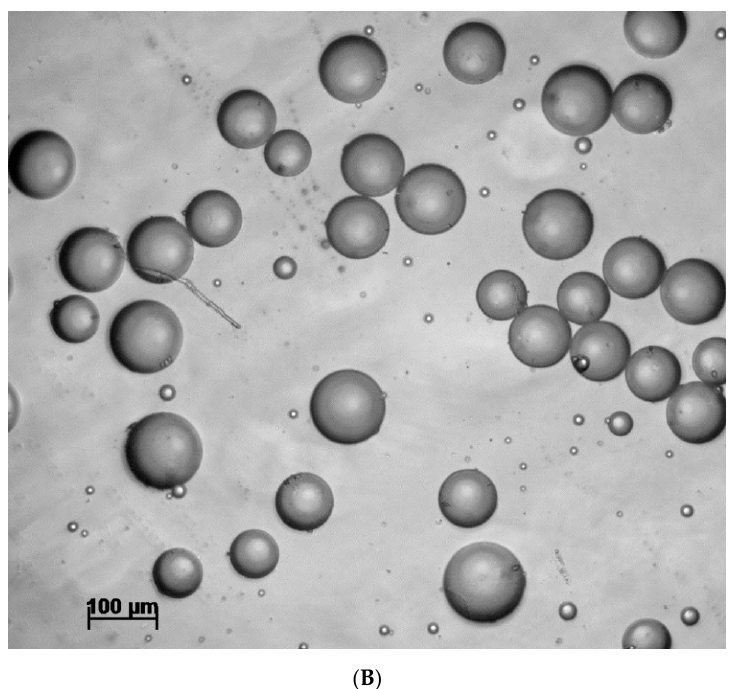
Figure 2. The representative snapshots of EAT adipocytes of patients from groups of patients with non-hypertrophied EAT adipocytes and with hypertrophied EAT adipocytes. ( A ) Patient from group of patients with non-hypertrophied EAT adipocytes, median of adipocytes diameter is 80.27 µ m; ( B ) patient from group of patients with hypertrophied EAT adipocytes, median of adipocytes diameter is 89.88 μ m. Light microscopy, magnification × 200. EAT, epicardial adipose tissue. The level of fasting glucose in patients from the second group exceeded the values in group of patients with non-hypertrophied EAT adipocytes by 14% ( p = 0.46, Table 1). However, the level of fasting insulin was 1.7 times lower in group of patients with hy- pertrophied EAT adipocytes compared to group of patients with non-hypertrophied EAT adipocytes ( p = 0.0039, Table 1). The parameters of postprandial glucose, postprandial in- sulin, glycated hemoglobin. or HOMA-IR did not differ between groups of patients with hypertrophied and non-hypertrophied EAT adipocytes. We did not reveal any differences in parameters of lipid profile, namely triacylglycerols, total cholesterol and its fractions, as well as atherogenic index (Table 1). Patients from group with hypertrophied EAT adipocytes also had higher values of body mass index, waist circumference (Table 1) and Gensini score (Table 4) values than those in group of patients with non- hypertrophied EAT